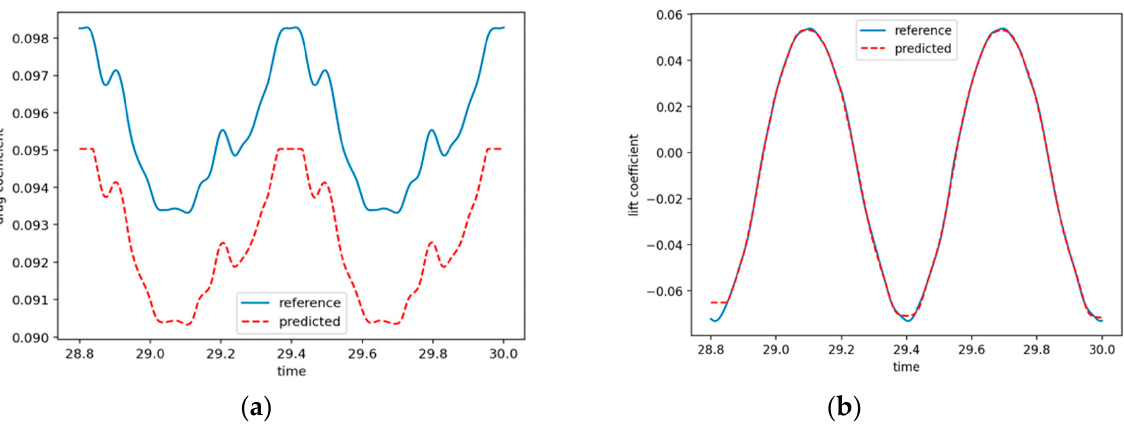
Figure 12. Reference aero force and predicted aero force at Re = 5000: ( a ) drag coe ffi cient; ( b ) lift coe ffi cient.